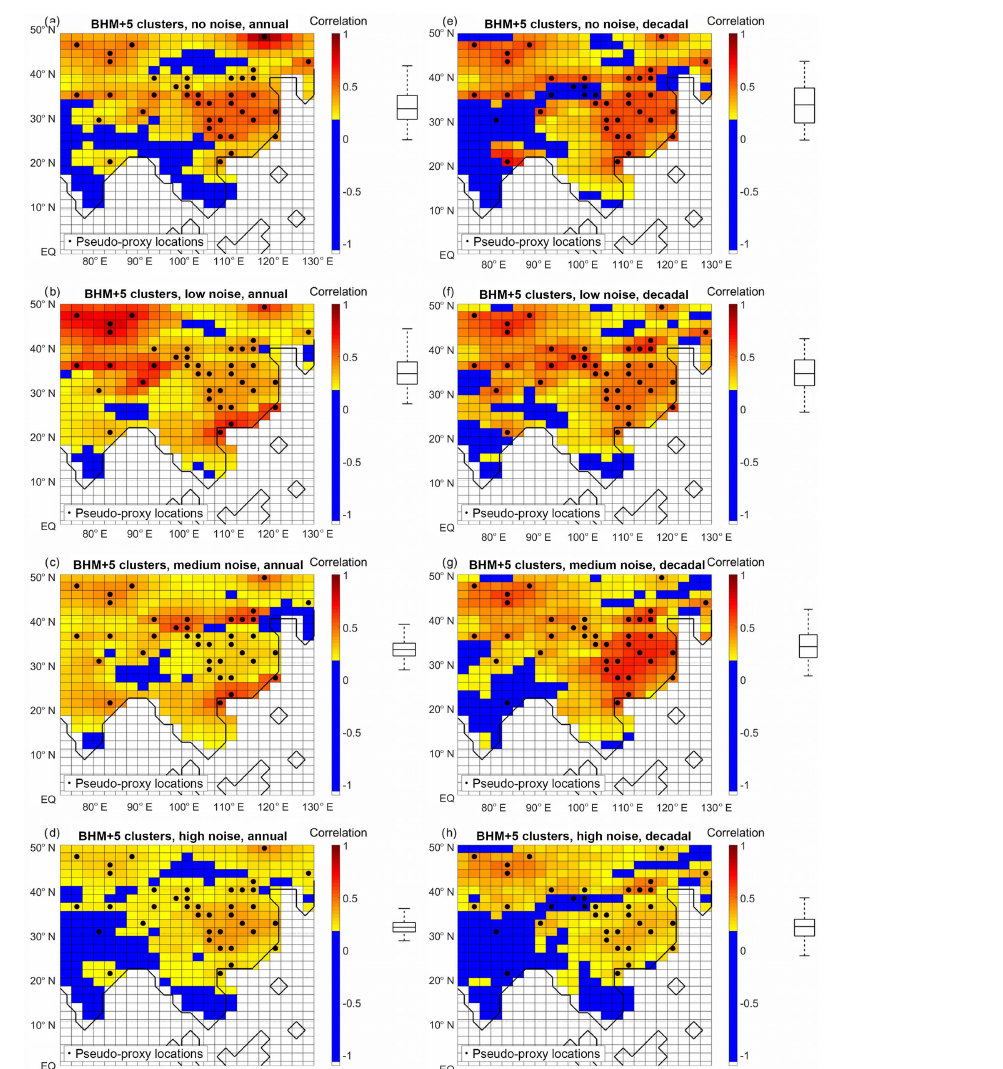
Figure 8. BHM + 5Clusters performance in terms of correlation with the target for different levels of noise at annual (a, b, c, d) or decadal (e, f, g, h) resolution. (a, b) No noise. (c, d) Low noise. (e, f) Medium-level noise. (g, h) High noise. The boxplots (indicating median, 25% and 75% percentiles and non-outlier limits) to the right of the colour bars show the distribution of the grid-point correlation coefficients. Black dots: pseudo-proxy